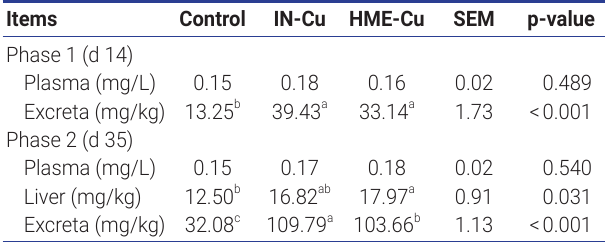
Table 6. Effect of dietary Cu concentrations and sources on small in- testinal morphology in broilers Items